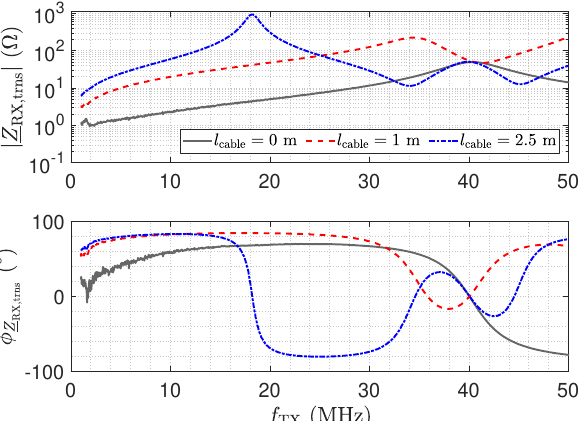
(cid:12) (cid:12) Figure 24. Measured magnitude of the transformed matched LCR input (cid:12) Z RX,trns (cid:12) and phase φ Z RX,trns impedance according to Figure 21, for three different transmission line lengths. The result for a length of 0m corresponds to Z RX . The impedance magnitude at 40MHz is about 50 Ω for all three cable lengths. The corresponding phase at 40MHz is close to 0 ◦